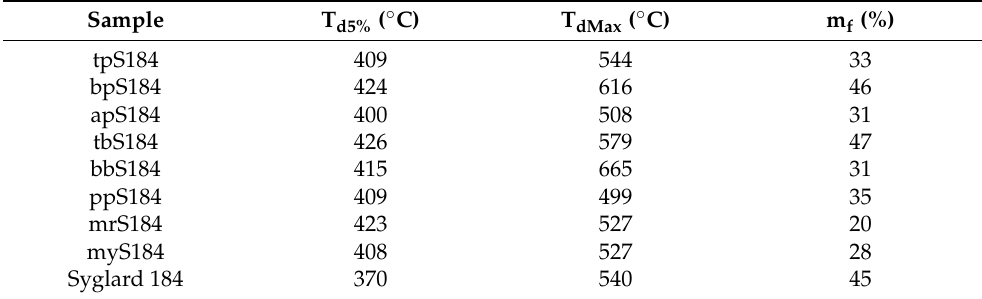
Table 4. Thermal properties of the 0.5 wt.% composite chromophoric sensors compared to Sylgard 184.